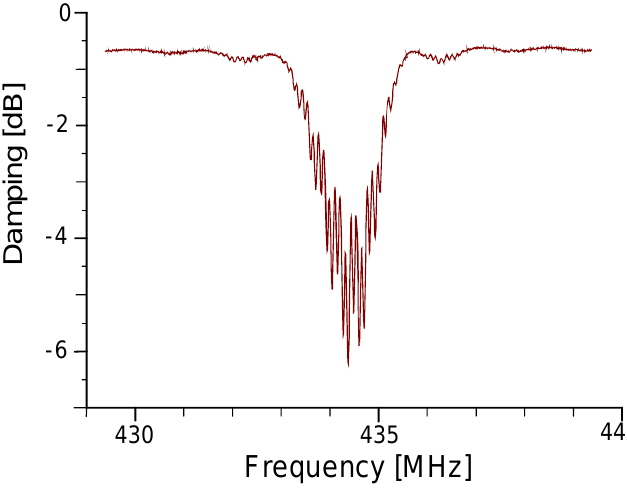
Figure 3. Sensor response in frequency domain of an RFID-Tag.